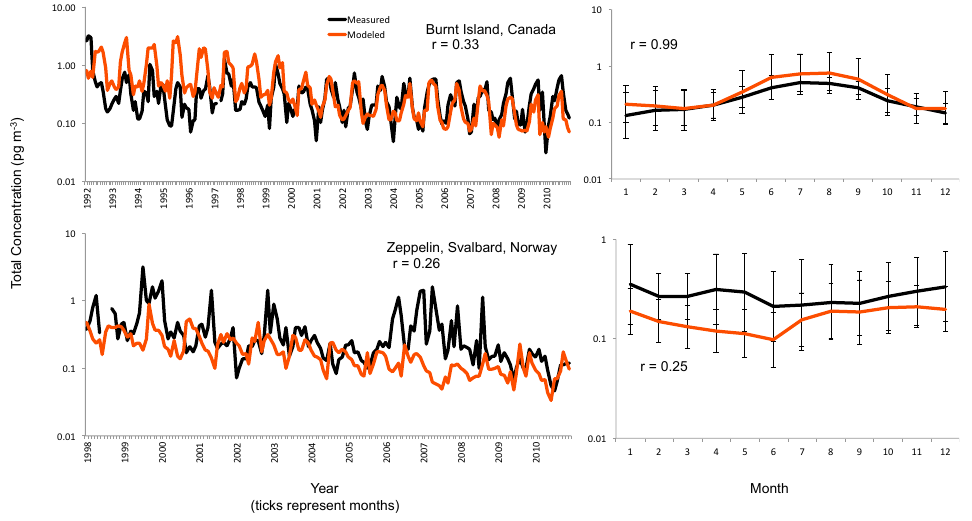
Figure 4. Total measured and simulated monthly mean concentrations of CB 153 at Burnt Island, Canada (top row), and Zeppelin, Norway (bottom row). The left-hand column is the full time series, while the right-hand column is an average of the data on the left over all